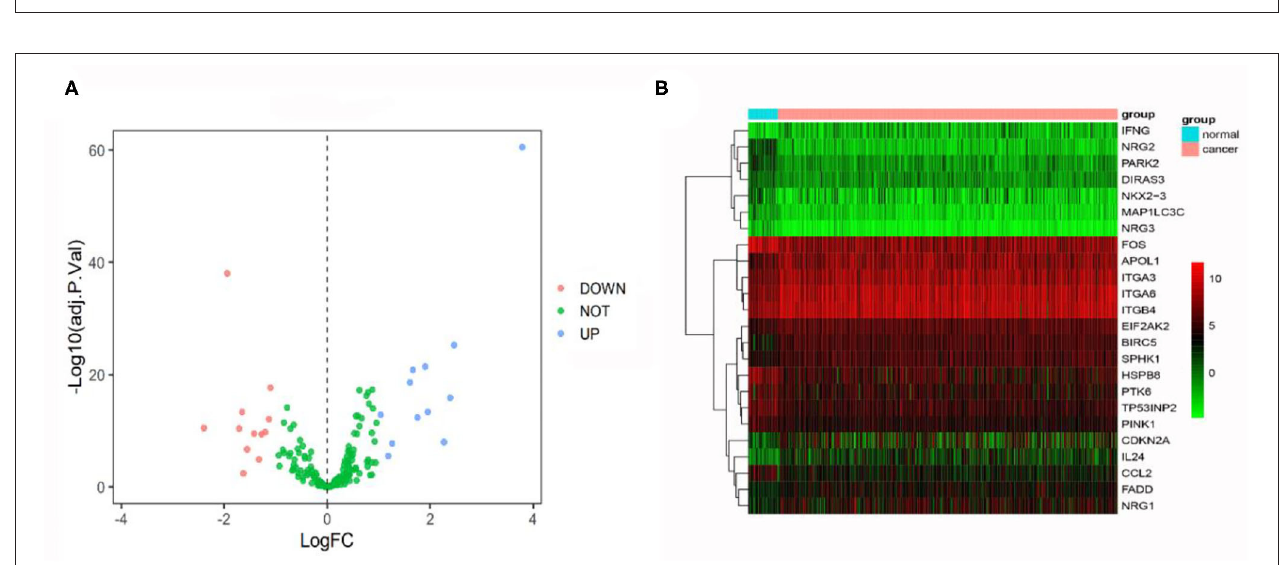
FIGURE 2 | (A) Volcano plot comparing autophagy-related gene expression for tumor and non-tumor tissues. A total of 24 genes were identified [red (down-regulated) and blue points (up-regulated)]. (B) Heatmap showing 24 genes in tumor tissues and adjacent non-tumor tissues.